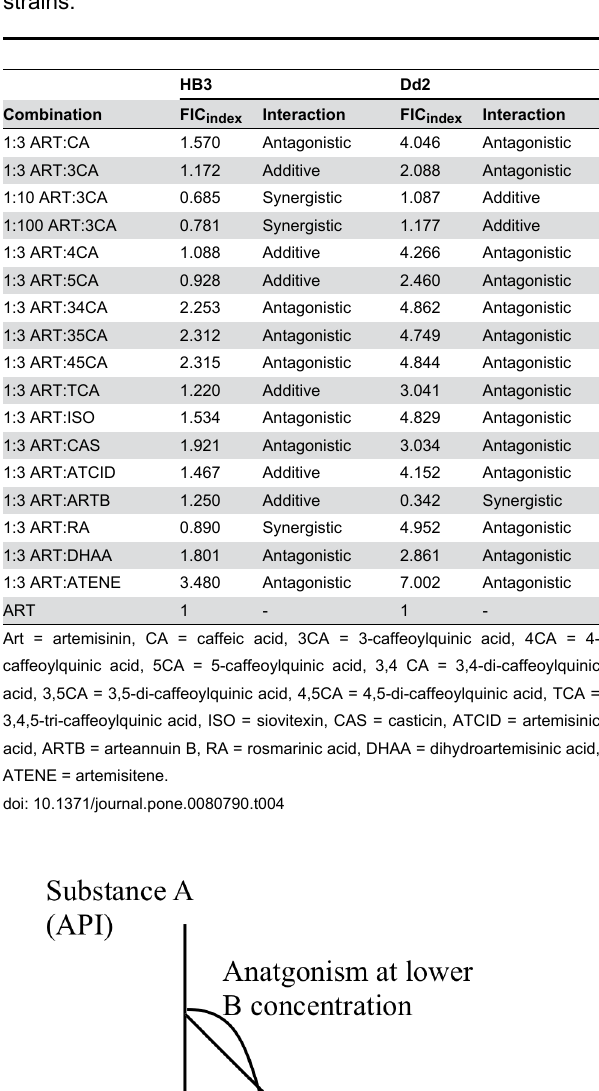
Table 4. Anti-plasmodial interactions of co-metabolites with artemisinin in CQ-sensitive (HB3) and CQ-resistant (Dd2) strains.